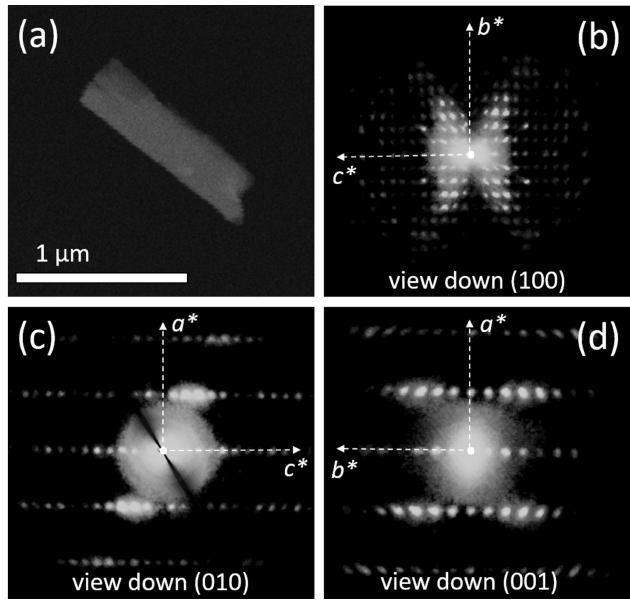
Figure 4 ( a ) HAADF–STEM image of a typical crystal of compound I, used for 3D ED data acquisition. ( b )/( c )/( d ) Reconstructed 3D ED data viewed along the main crystallographic directions. Note that these are projections of a 3D diffraction volume and not 2D oriented ED patterns, and therefore axial extinctions are not visible.